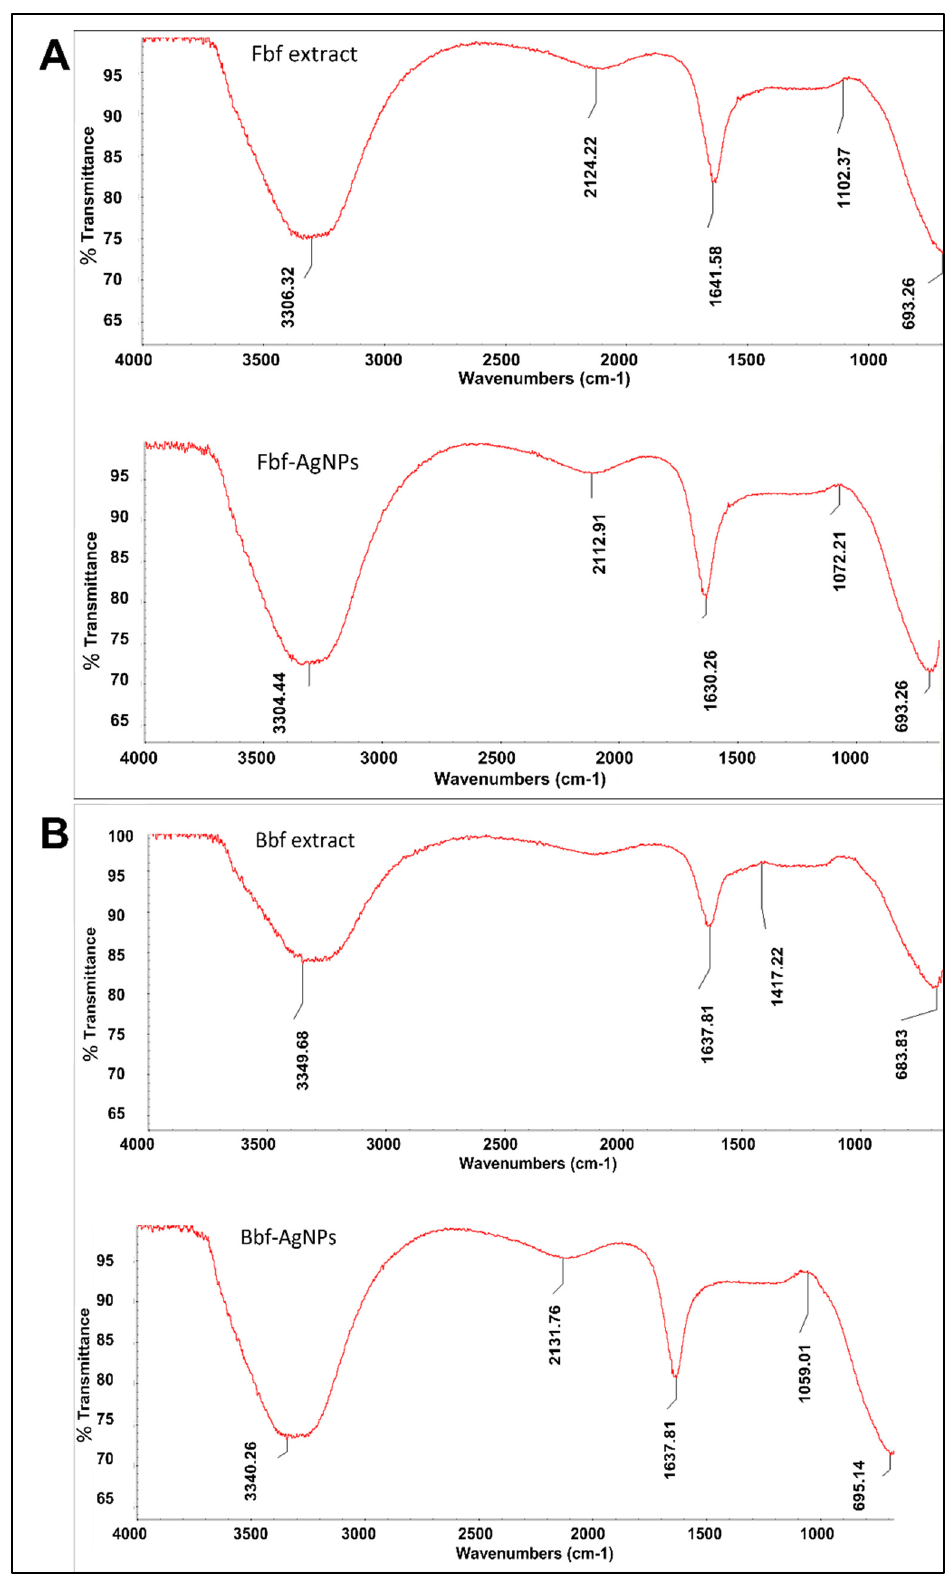
Figure 4. FTIR analysis of the biosynthesized nanoparticles and the fern extracts. ( A ) Fbf extract and Fbf-AgNPs and ( B ) Bbf extract and Bbf-AgNPs.